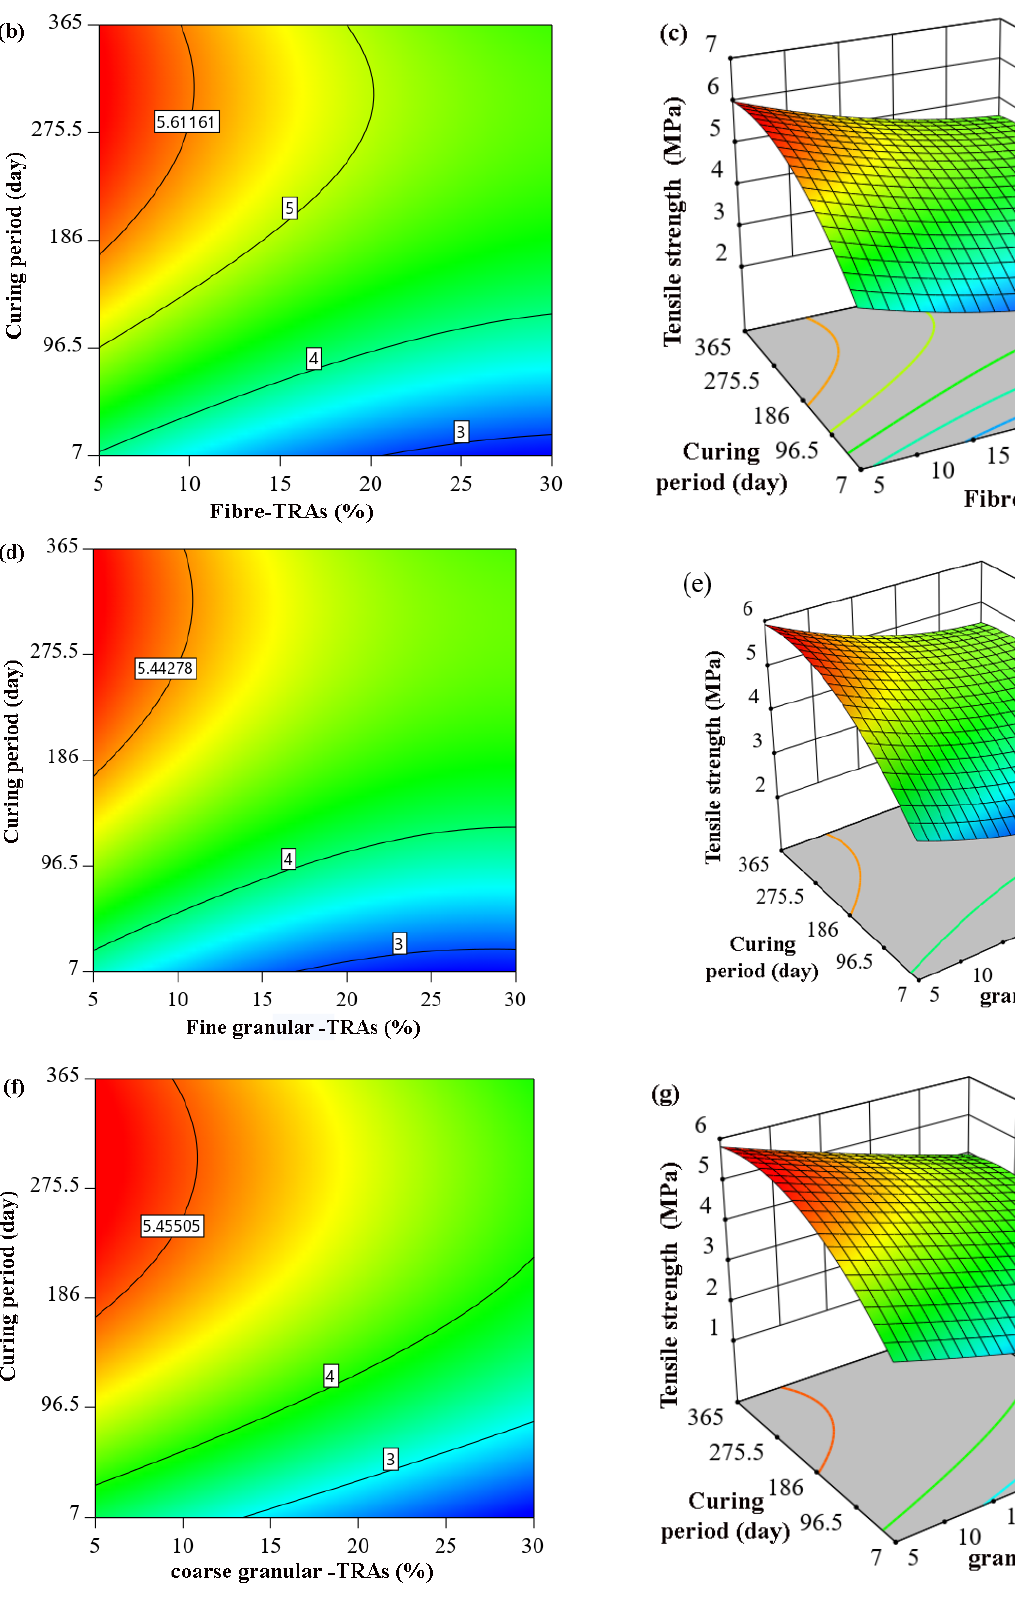
Figure 10. Effect of different types and concentrations of TRAs on splitting tensile strength in POFA modified concrete, ( a ) Experimental work, ( b , c ) fibre rubber, ( d , e ) fine rubber, and ( f , g ) coarse rub- ber.